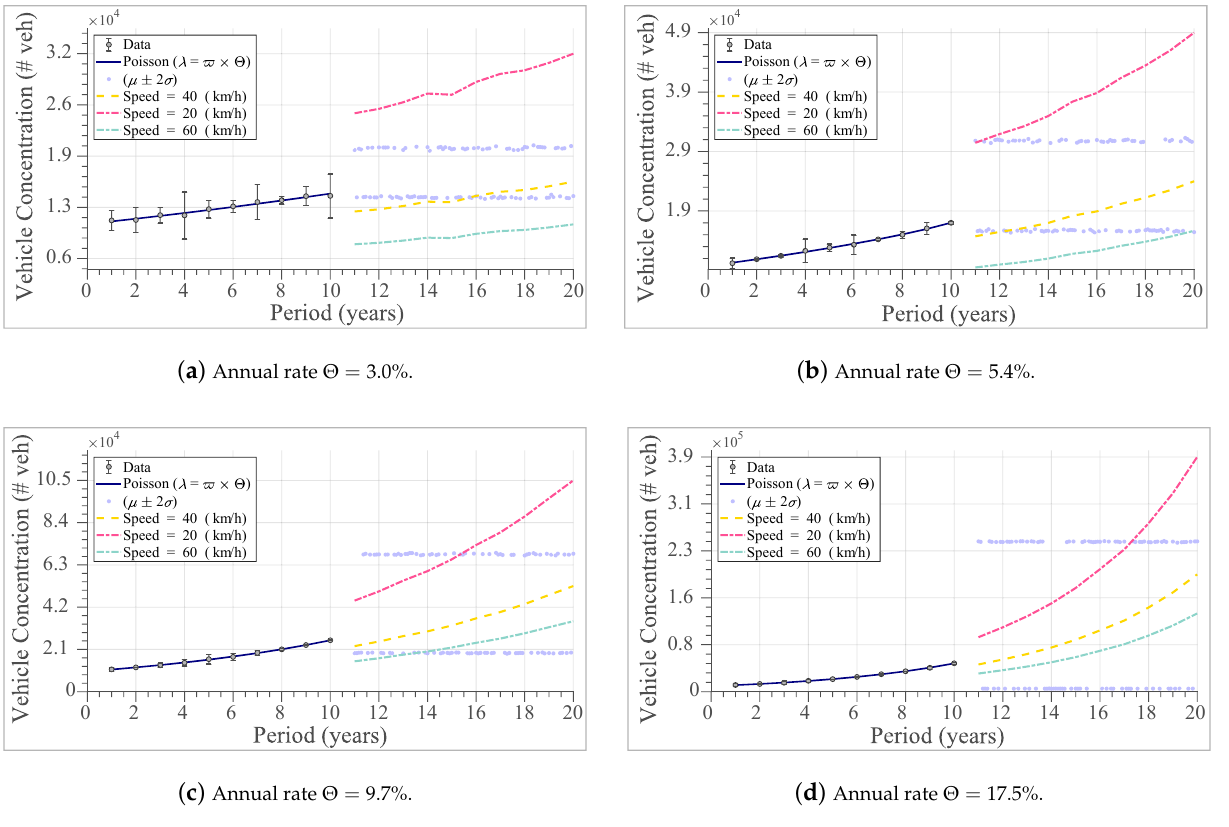
Figure 5. Case A: Microscopic traffic flow analysis using discrete Poisson probability.